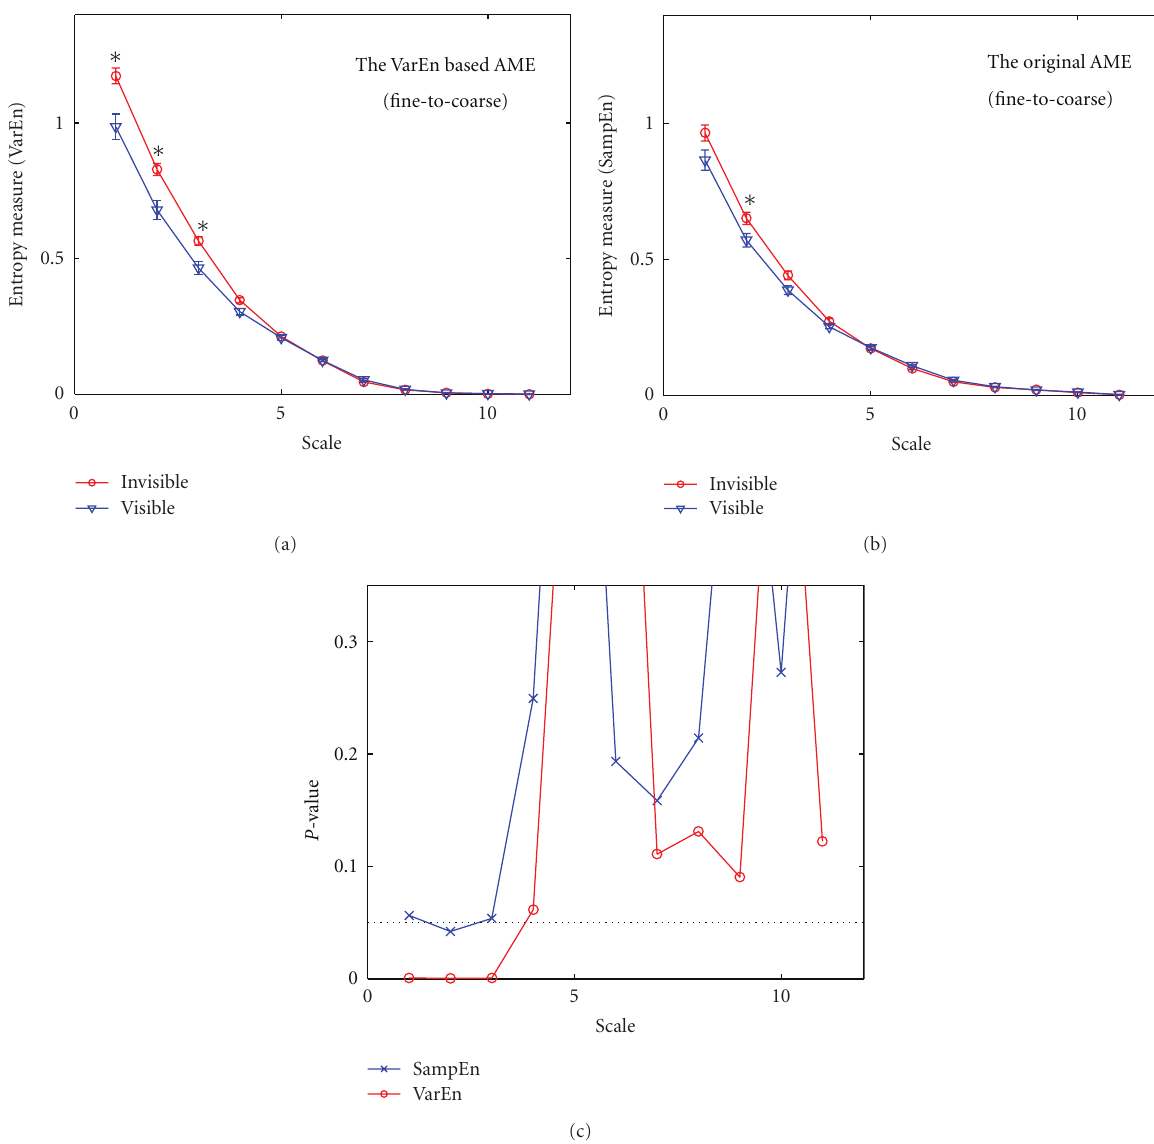
Figure 4: Fine-to-coarse comparison for the AME with VarEn (a) and the AME with SampEn (b) for discriminating the Invisible (red circle) and the Visible conditions (blue triangle) over multiple scales. For the AME with VarEn (a), significant di ff erences occur at the 1st–3rd scales, whereas for the AME with SampEn (b) significant di ff erence only occurs at the 2nd scale. Conventions are the same as in Figure 3. The P values based on our VarEn and the SampEn along the fine-to-coarse scales are also compared (c), in which the horizontal black dotted line refers to the significance level ( P = 0 . 05). Note that the P values greater than 0.35 are